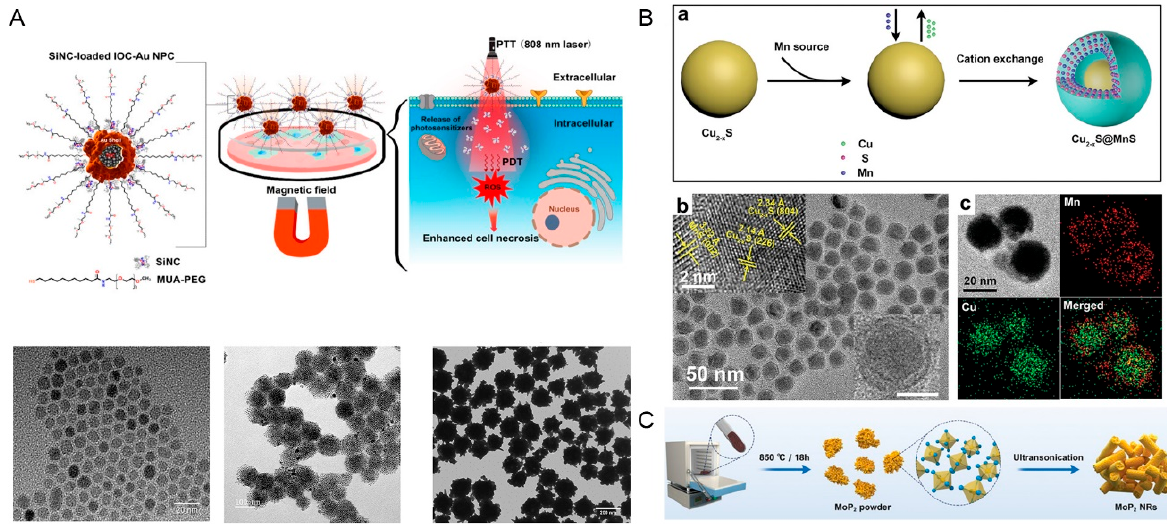
Figure 4. Schematic illustrations of several metal compounds. ( A ) Schematic illustration of gold nanopopcorns containing a self-assembled iron oxide cluster core coated with near-infrared-absorbing photosensitizer silicon 2,3-naphthalocyanine dihydroxide and stabilization with poly (ethylene glycol) linked with 11-mercaptoundecanoic acid (MUA-PEG/SiNC/IOC-Au NCPs) and TEM images of IO NPs, IOCs, and IOC–Au NPCs. ( B ) Synthesis scheme and TEM morphology of Cu 2 − x S@MnS core- shell nanoparticles (Cu 2 − x S@MnS CSNPs). ( a ) Synthesis scheme of Cu 2 − x S@MnS CSNPs. ( b ) TEM morphology of as-synthesized CSNPs. Inset in the upper left corner: high-resolution images. Inset in the lower right corner: TEM image of a single CSNP. ( c ) EDS elemental mapping of Cu 2 − x S@MnS CSNPs. ( C ) Morphology and characterization of as-synthesized molybdenum diphosphate nanorods (MoP 2 NRs). Adapted with permission from [86,88,90]. Copyright 2022, John Wiley and Sons, American Chemical Society and John Wiley and Sons, respectively.